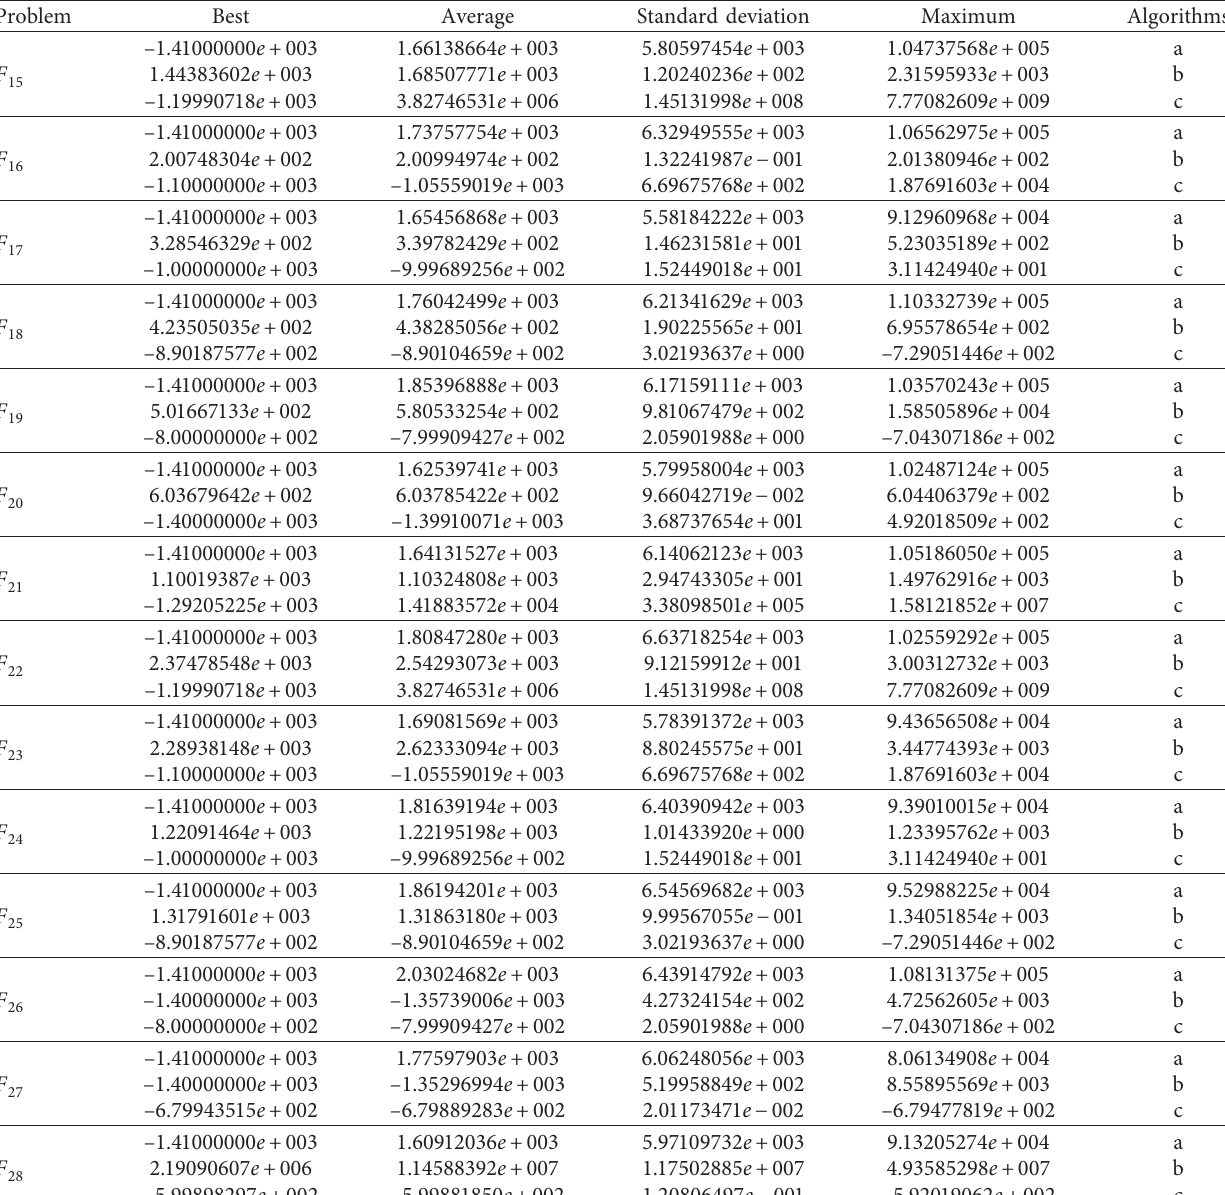
Table 7: The experimental results gathered by (a) MSIA, (b) ACO, and (c) FA by solving the CEC ′ 13 in 50 dimensions [54]. Problem Best Average Standard deviation Maximum